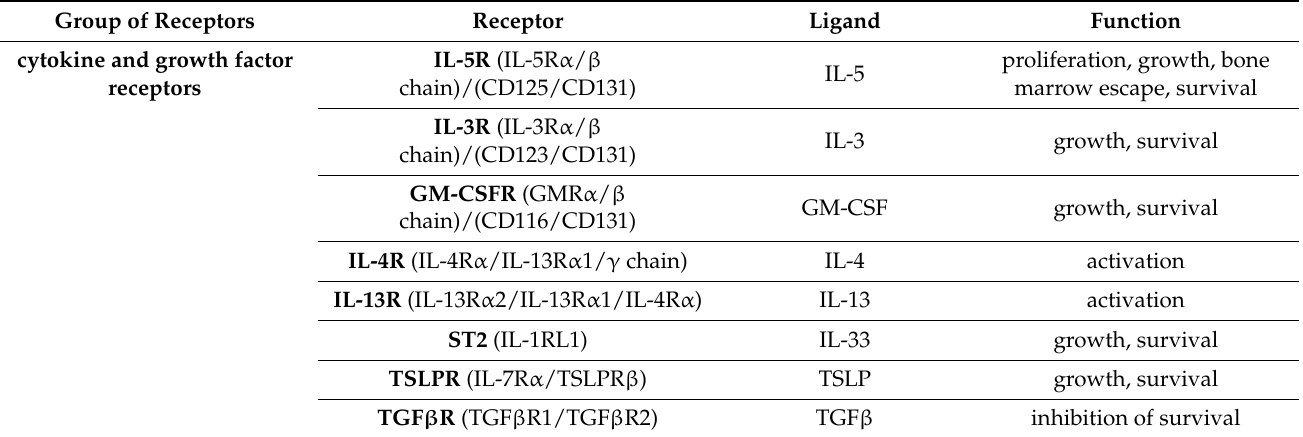
Table 2. Eosinophil receptors.